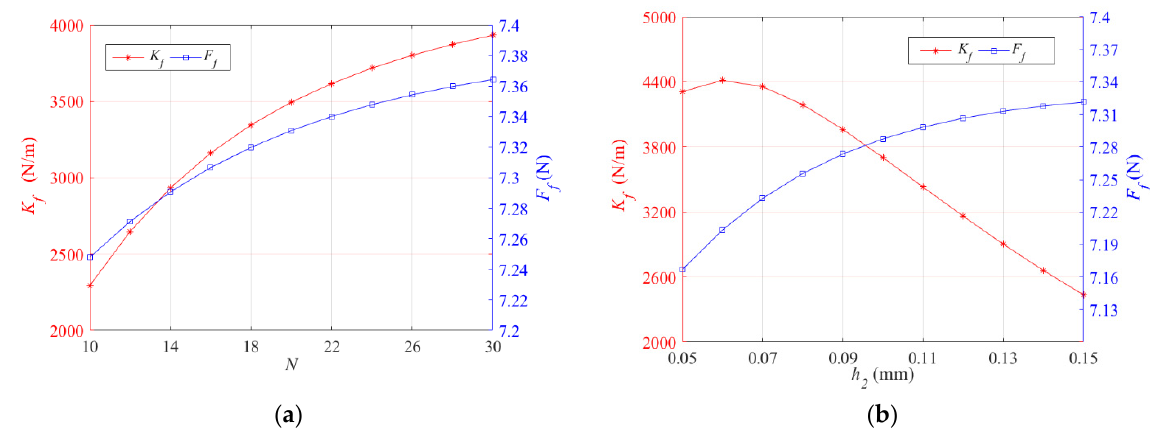
Figure 13. Influence of the groove number and groove depth on stiffness and hydrodynamic force: ( a ) Number of the spiral grooves; ( b ) Spiral groove depth.